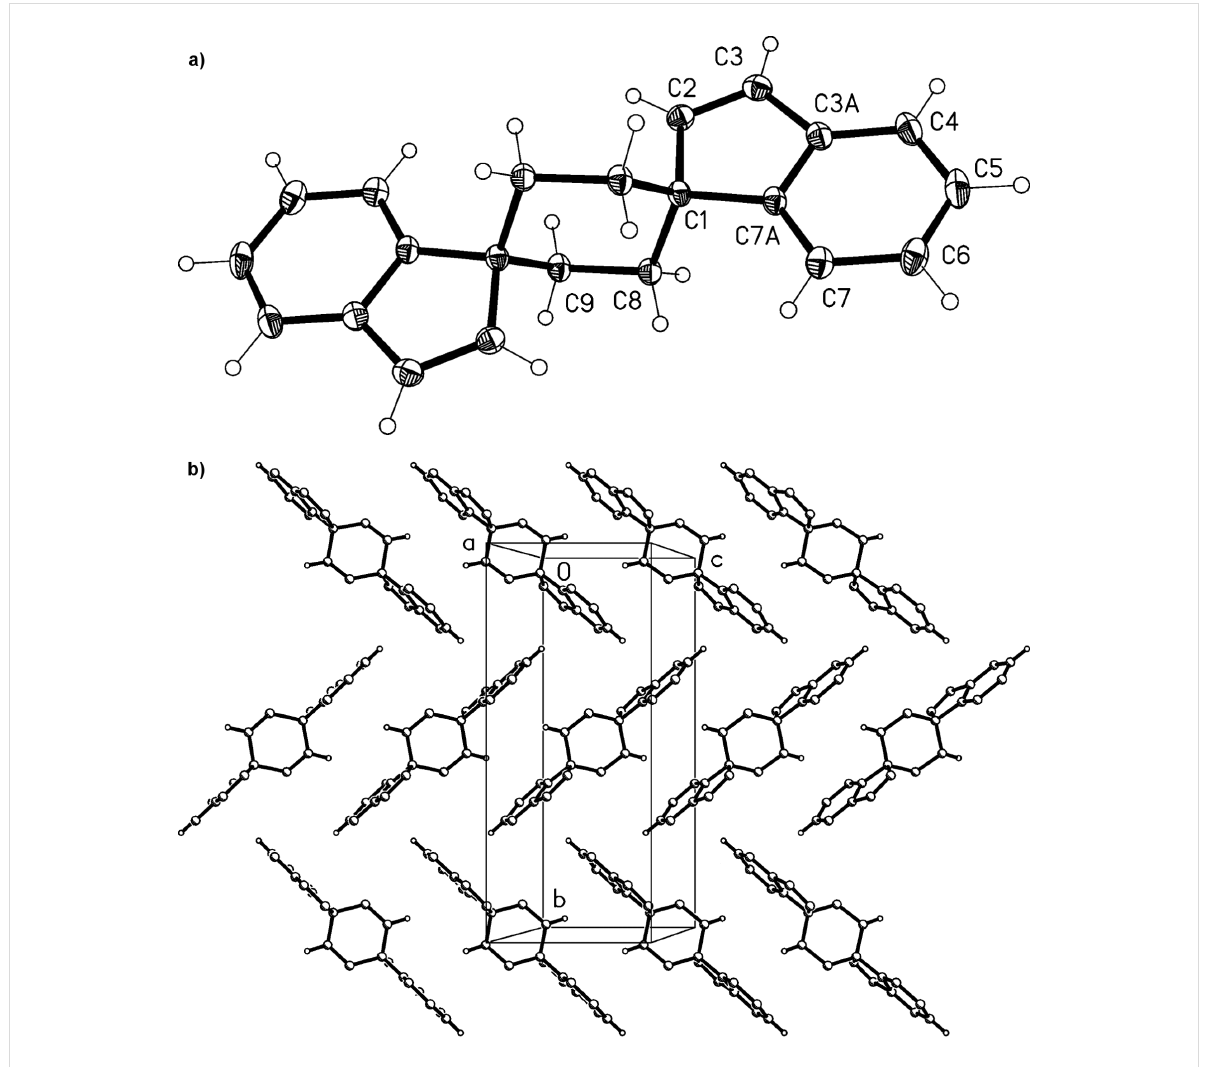
Figure 4: a) The molecule of compound 24 in the crystal. Ellipsoids represent 50% probability levels. Only the asymmetric unit is numbered. b) Packing diagram of compound 24 viewed perpendicular to the bc plane. C–H··· π contacts to the centroid of the aromatic six-membered ring (seen side-on) can be recognized, but are not drawn explicitly. H atoms not involved in these contacts are omitted.